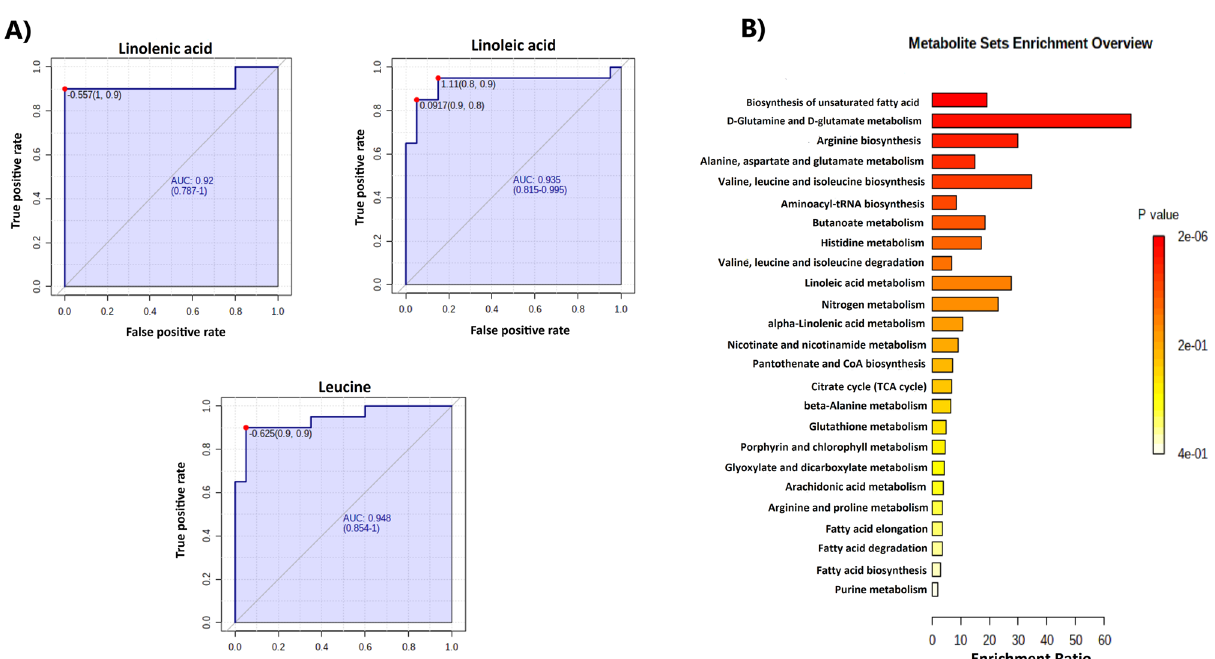
Figure 3. ( A ) ROC curve analyses of the three metabolites’ ability to distinguish MTC patients from healthy subjects. ( B ) Metabolic Set Enrichment Analysis (MSEA) indicating top 25 metabolic pathways perturbed upon